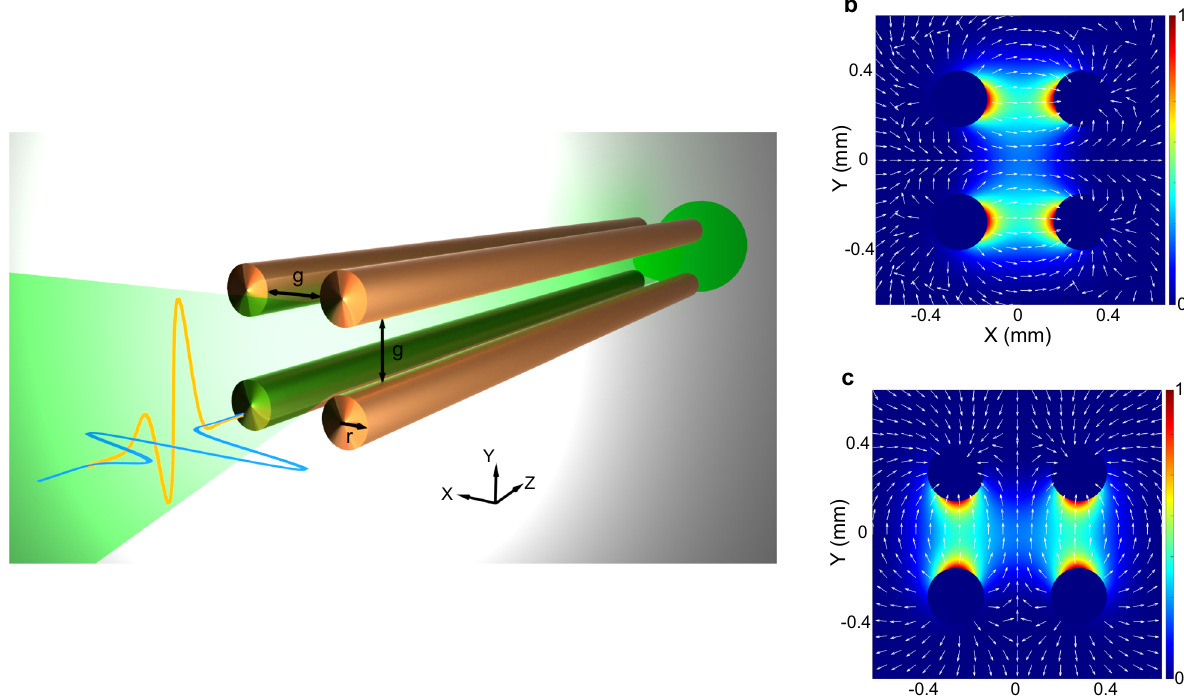
Fig. 2 Geometry and fundamental TEM modes of the four-wire waveguide (FWWG). a Schematic of the FWWG architecture. The FWWG consists of four identical copper wires (radius r = 127 µ m) equally separated by an air gap ( g = 300 µ m), arranged into a square geometry. b , c Simulated electric fi eld intensity distributions of the fundamental TEM modes evaluated at 0.5 THz, TEM x ( b ), and TEM y ( c ), which can be ef fi ciently excited by x -polarized and y - polarized THz beams, respectively. The arrows in the 2D distributions indicate the local electric fi eld polarization